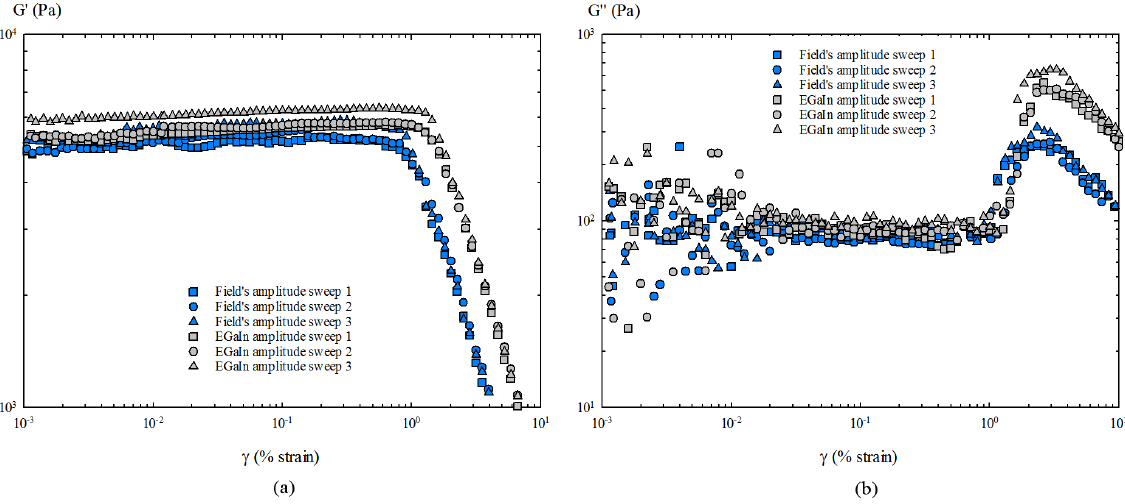
Figure 3. Results of the oscillatory amplitude sweep tests: ( a ) Storage modulus G (cid:48) . ( b ) Loss modulus G (cid:48)(cid:48)